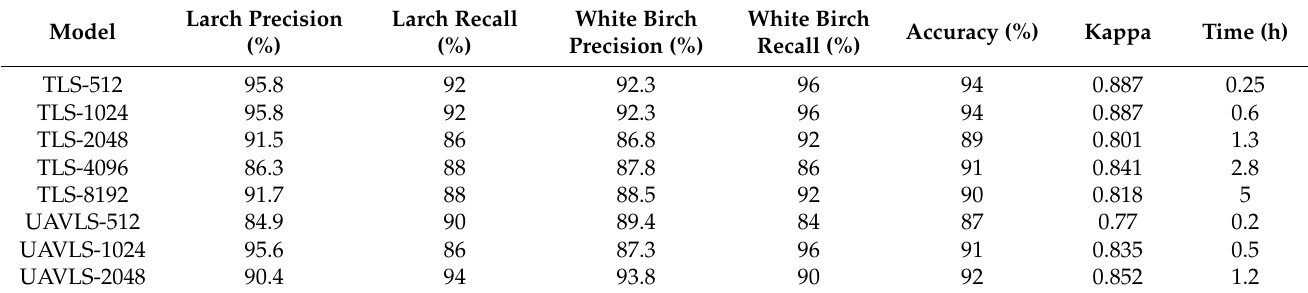
Table 5. Accuracy evaluation coefficient and calculation time of each